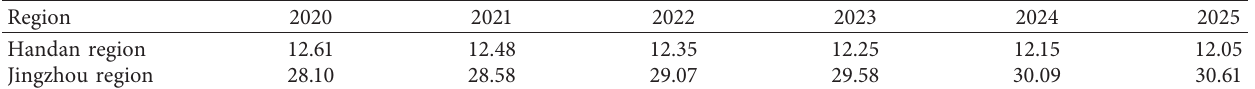
Table 3: Forecast value of agricultural water consumption in the study area in the next five years.